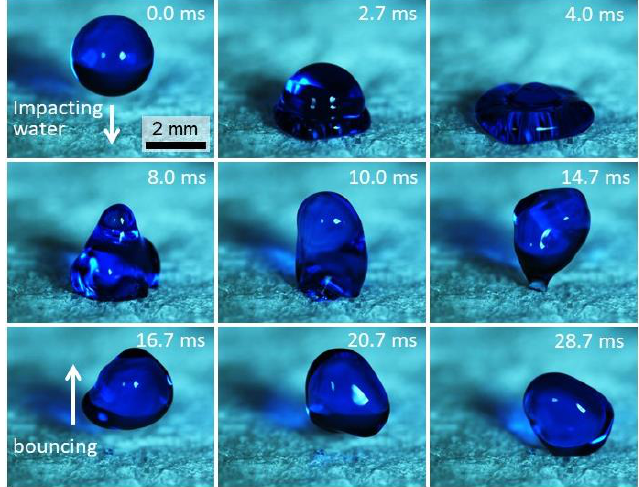
Figure 9. High-speed image sequence of a water drop impacting and rebounding from CNF foams. Impact conditions: drop diameter D = 2.71 mm, impact velocity V = 0.39 m/s. Water is blue-stained to improve contrast. The corresponding time for each frame is indicated.